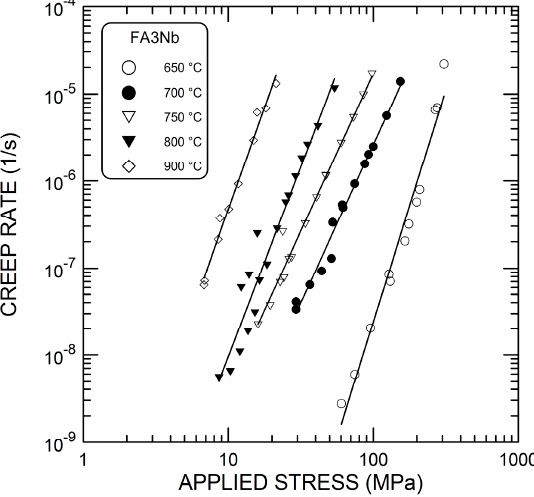
Figure 3. Dependence of the creep rate of the FA3Nb alloy on applied stress.